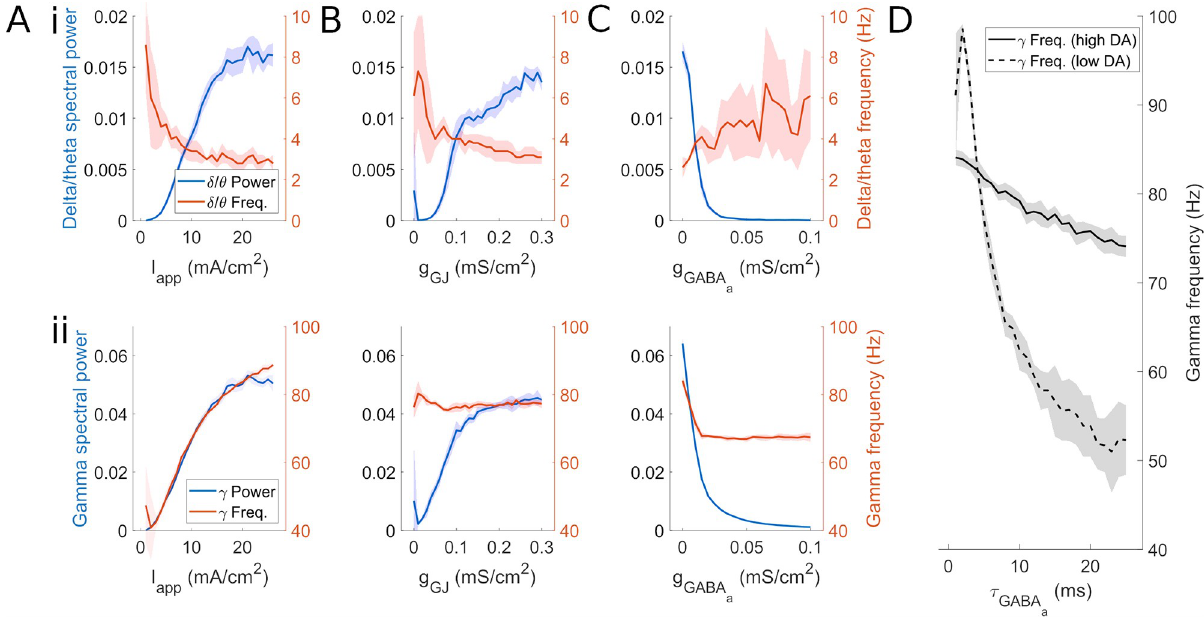
Fig 3. FSI network rhythms change with background excitation and synaptic strength. Power and frequency of δ / θ and γ rhythms in FSI network mean voltage as a function of (A) tonic input current, (B) gap junction conductance, and (C) GABA A conductance. The parameters not being varied in plots A-C are held at the high DA values ( I app = 14 μA / cm 2 , g GJ = 0.3 mS / cm 2 , g value over 10 simulations per point. Shading represents standard deviation from these means. Power spectra are derived using Thomson’s multitaper power spectral density (PSD) estimate (MATLAB function pmtm). (D) Gamma frequency as a function of GABA a synaptic time constant and level of dopamine. High DA values are as previously stated; low DA values are I app = 7 μA / cm 2 , g GJ = 0.15 mS / cm 2 , g